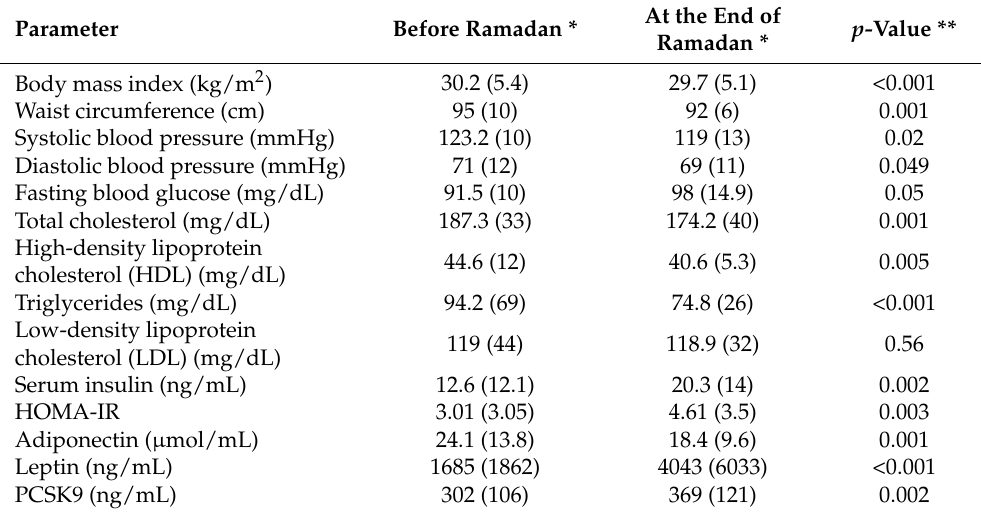
Table 2. Changes in anthropometric and biochemical variables before and during Ramadan fasting. Parameter Before Ramadan *